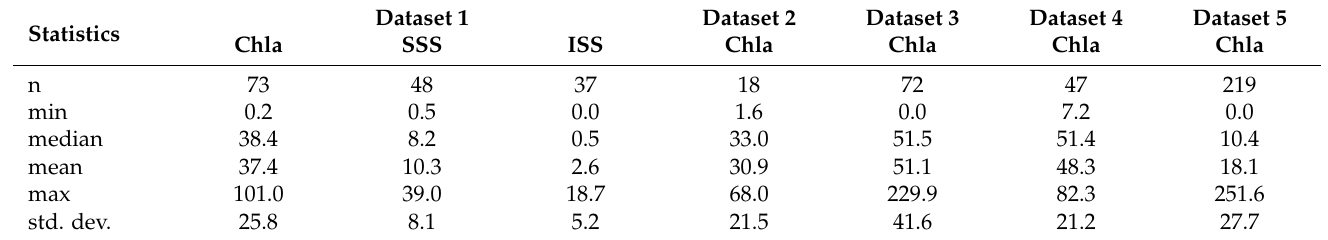
Table 2. Descriptive statistics of the five datasets that were used for model fitting or